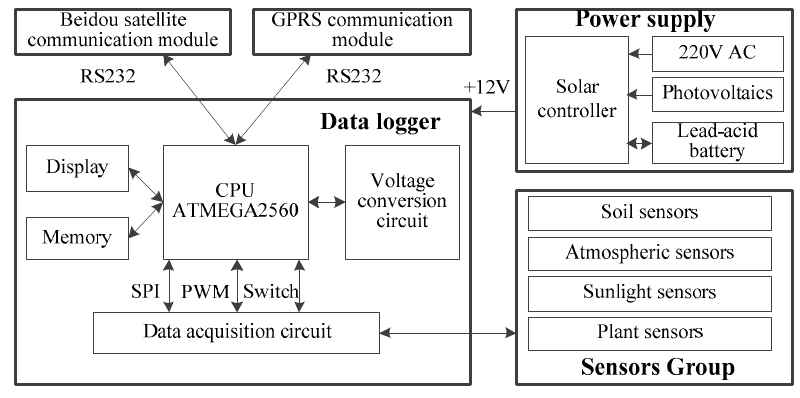
Figure 2. Block diagram of the system hardware.